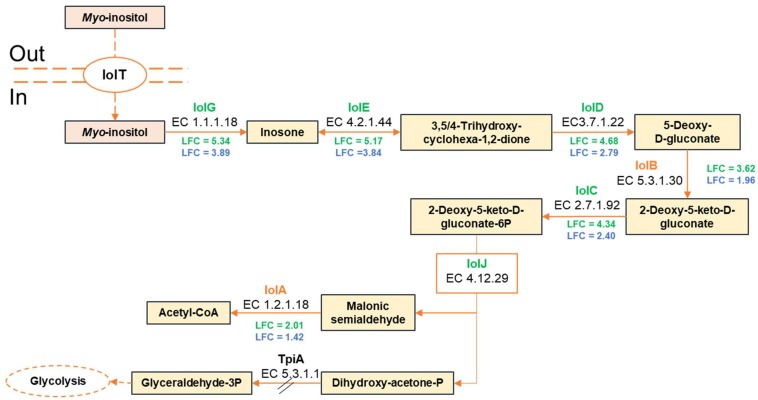
Predicted pathway of myo-inositol catabolism by B. thermosphacta strains CD 337 and TAP 175 in meat juice. LFC values were represented with a color code depending on strain: CD 337 (green); TAP 175 (blue).